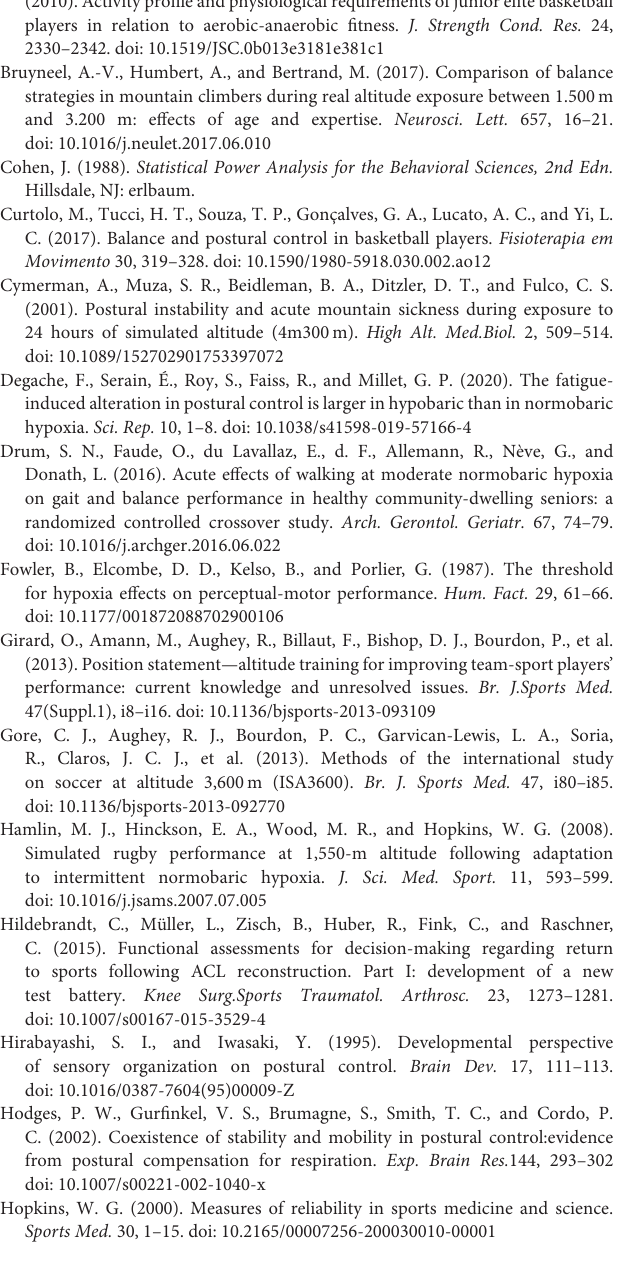
balance tests; NOR, normoxic condition; HYP, normobaric hypoxia condition. ∗ Indicates significant difference between elite and sub-elite players, P < 0.05. † Indicates significant difference from values obtained at first measurement (after the initial 15min of resting inside the chamber), P < 0.05. # Indicates a significant difference between HYP and NOR, P < 0.05. ### P < 0.001. Supplementary Table 1 | Reliability parameters for the SLBT at DL and NDL in NOR and